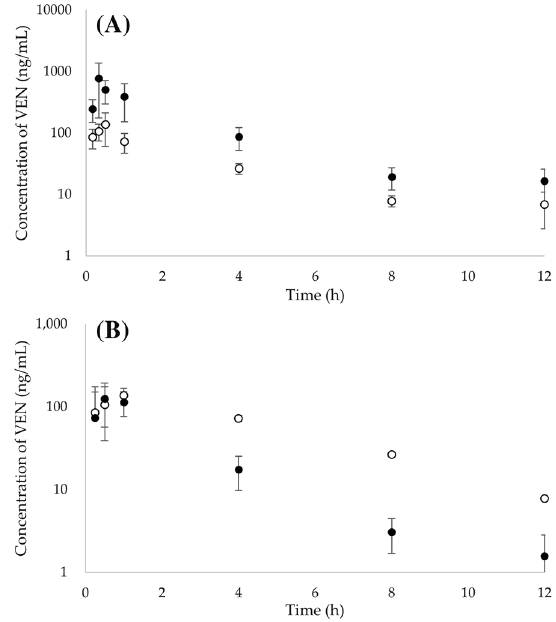
Fig. 3 Mean plasma concentration–time curves of VEN in A rats and B dogs that had received an oral administration of 30 mg/kg and 0.5 mg/kg of VEN, respectively (key: opened circles, male; closed circles, female). Data were represented as mean standard deviation ± of n 3 (for rats) or n 6 (for dogs) = = Table 5 Summary of systemic PK parameters following oral administration of VEN to rats and